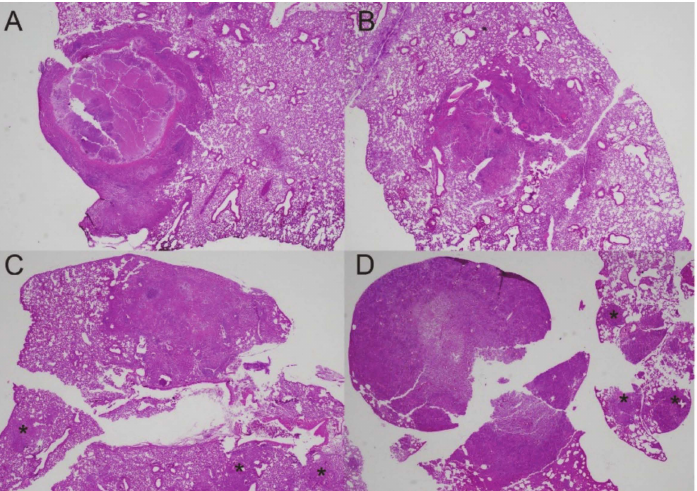
Figure 8. Granulomas at different time points before and after DXM suppression. ( A ) Controlled granuloma in untreated mouse; ( B ) after 14 days of DXM, the structure of the lesion is lost; ( C ) 6 weeks after stopping DXM, the pyogranulomatous lesion has not recovered the structure seen in ( A ), and there are additional centers of pyogranulomatous inflammation in the lung lobe (asterisks); ( D ) in a mouse treated continuously with DXM, the primary lesion on the left side of the image is intensely neutrophilic with innumerable spherules, and there are multiple additional lesions with many spherules beyond the large initial one (asterisks). (Stain—HE; magnification × 20).